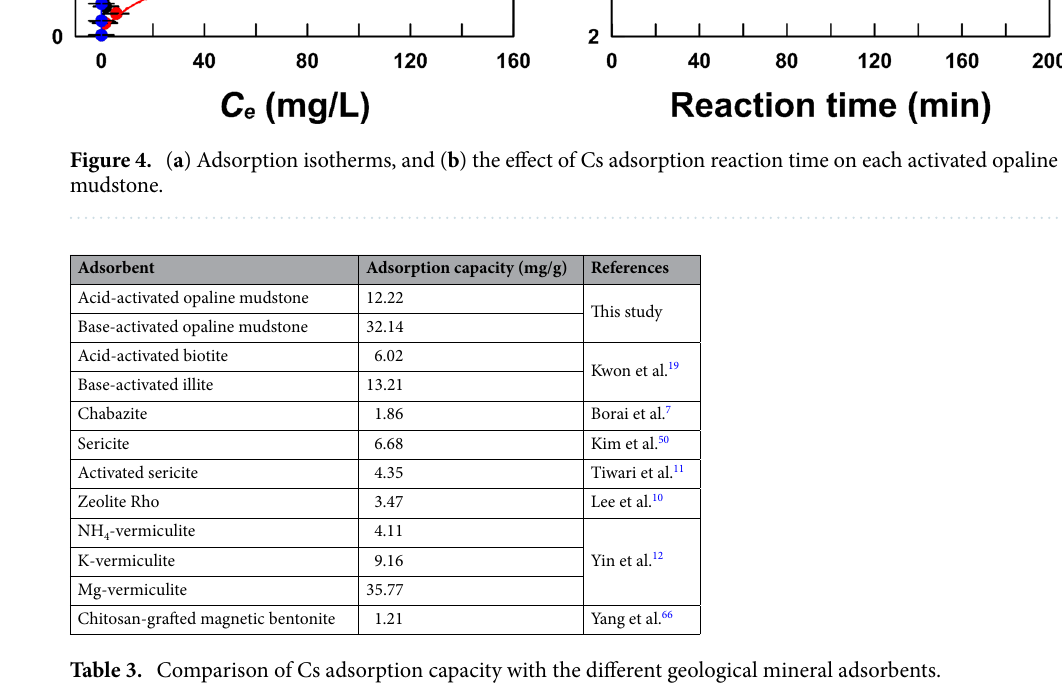
Table 3. Comparison of Cs adsorption capacity with the different geological mineral adsorbents.